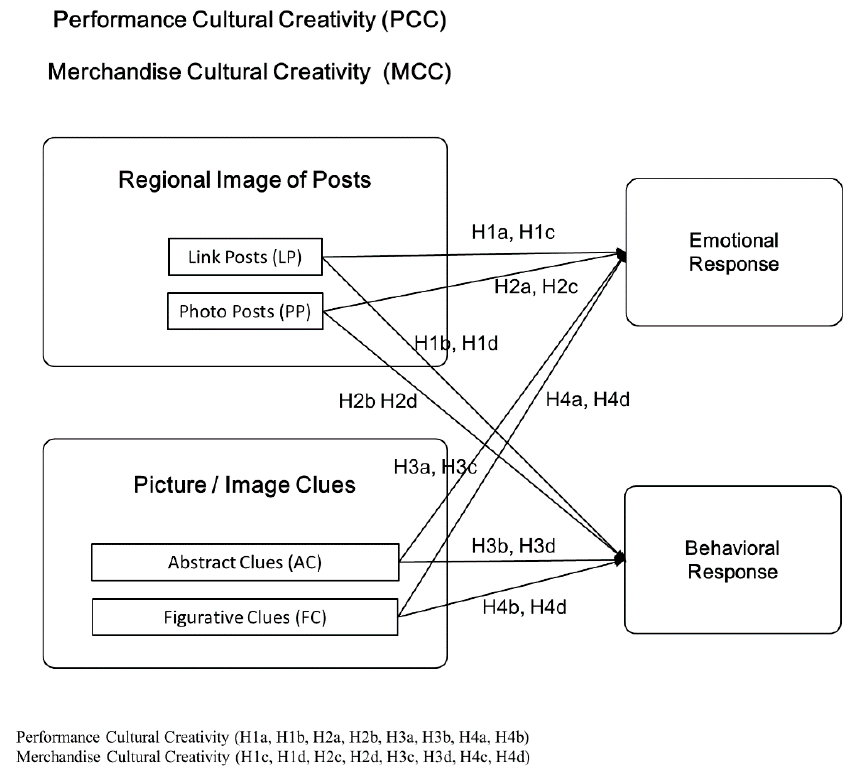
Figure 1. Extended research model.